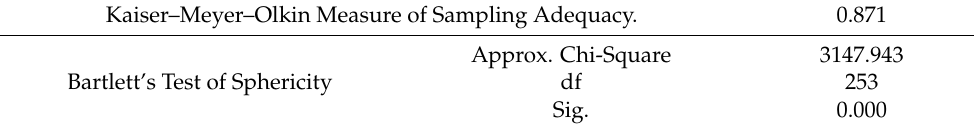
Table 1. KMO and Bartlett sphere